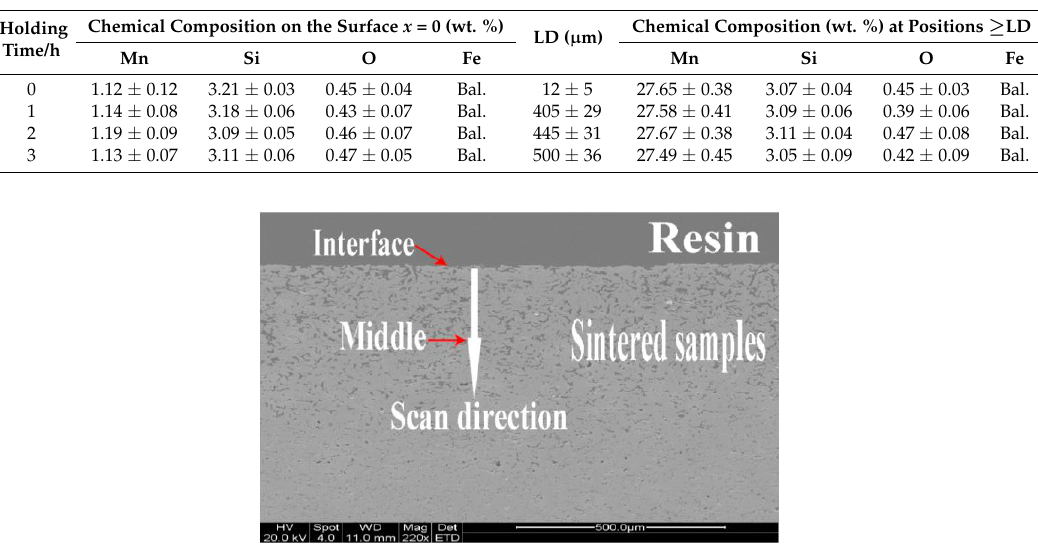
Figure 2. Weight loss rate of the sintered MM Fe-Mn-Si samples as a function of the isothermal holding time.